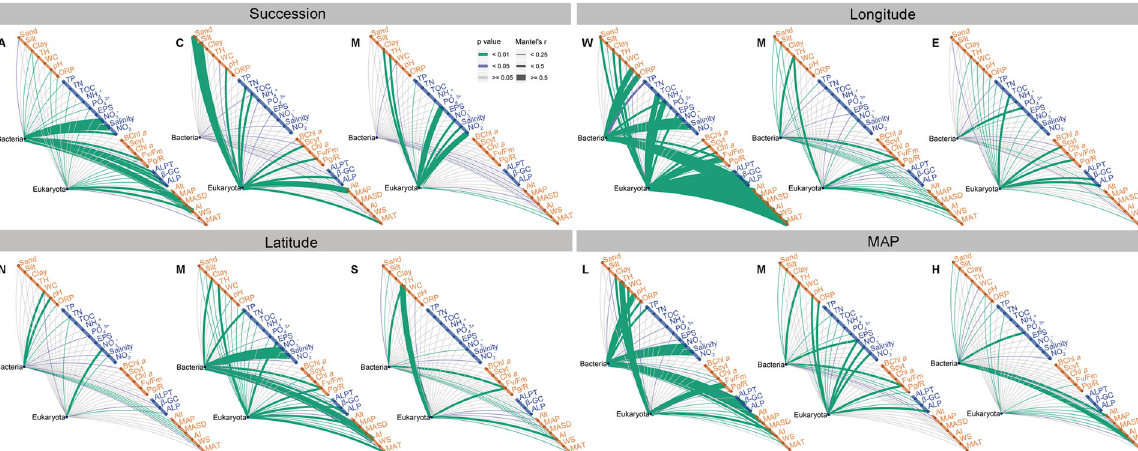
Fig. 3 Correlations between environmental factors and microbiome community at phylum level by Mantel test. The environmental factors were divided into fi ve categories: soil properties (sand, silt, clay, thickness (TH.), water content (WC), pH, oxidation-reduction potential (ORP)), nutrition and ions (total phosphorus (TP), total nitrogen (TN), total organic carbon (TOC), NH 4 + , PO 43 + , extracellular polysaccharide (EPS), NO 3 − , salinity, NO 2 − ), photosynthesis and pigments (bacteriochlorophyll a (BChl a ), scytonemin (Scyt.), chlorophyll a (Chl a ), variable fl uorescence/maximal fl uorescence (Fv/Fm), gross photosynthesis/respiration (Pg/R), extracellular enzyme activity (soil alkaline protease (ALPT), and soil- β -glucosidase ( β -GC), soil alkaline phosphatase (ALP)), and microclimate (altitude (Alt.), mean annual precipitation (MAP), mean annual sunshine duration (MASD), aridity index (AI), windspeed (WS), mean annual temperature (MAT)), separated by yellow and blue. The variables that were most strongly correlated with bacterial and eukaryotic communities were salinity ( r = 0.81) and MAP ( r = 0.32) in A crust; scyt. ( r = 0.24) and silt ( r = 0.81) in C crust; WC ( r = 0.24) and NO 2 − ( r = 0.65) in M crust; salinity ( r = 0.81) and Fv/Fm ( r = 0.75) in West (W); TH. ( r = 0.47) and Fv/Fm ( r = 0.43) in Mid-longitude (M); PO 43 + ( r = 0.28) and ALP ( r = 0.34) in East (E); WC ( r = 0.30) and NO 3 − ( r = 0.45) in North (N); salinity ( r = 0.81) and Fv/Fm ( r = 0.45) in Mid-latitude (M); TH. ( r = 0.39) and TH. ( r = 0.54) in South (S); salinity ( r = 0.80) and TH. ( r = 0.58) in Low-precipitation (L); TH. ( r = 0.47) and NO 3 − ( r = 0.36) in Mid-precipitation (M); Alt. ( r = 0.39) and AI ( r = 0.25) in High precipitation (H).